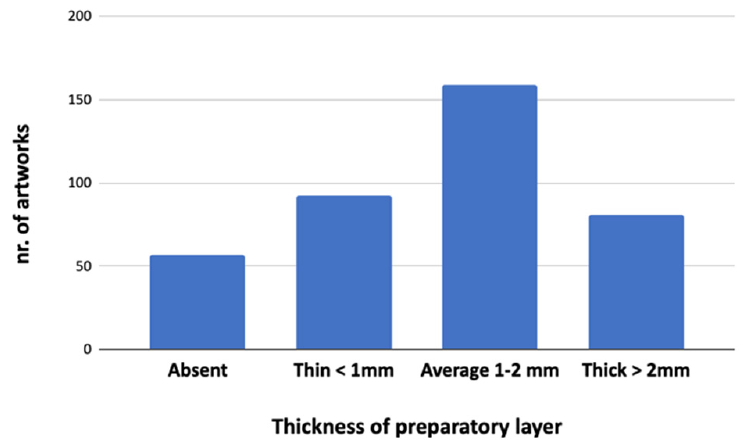
Figure 9. Distribution of artworks based on grades of preparatory layer thickness.